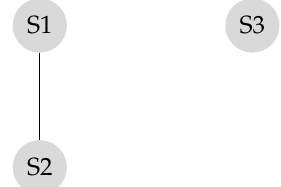
Figure 6. Disconnected graph with an isolated